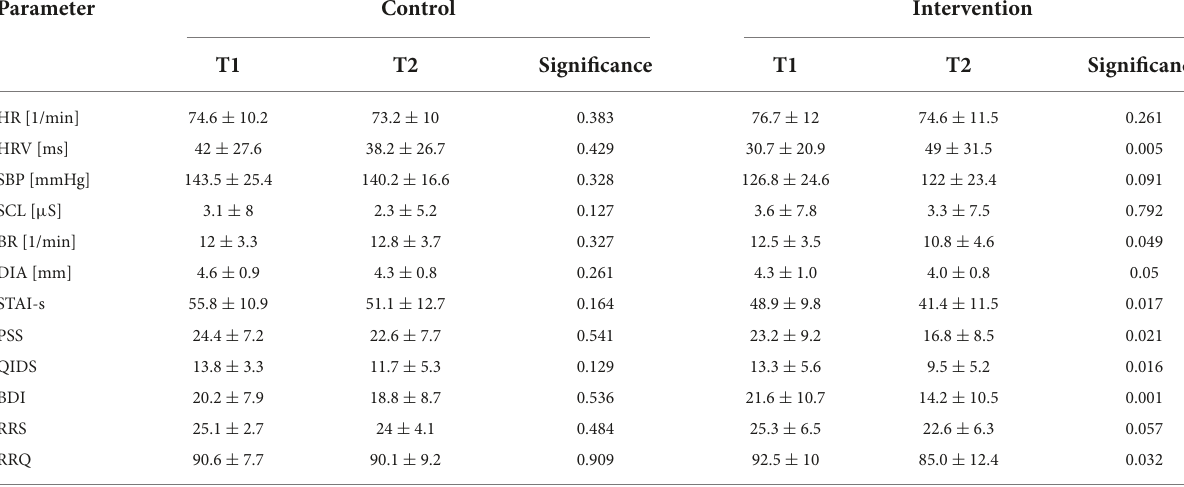
TABLE 3 Changes in autonomic function and psychopathological state after biofeedback intervention and control condition.